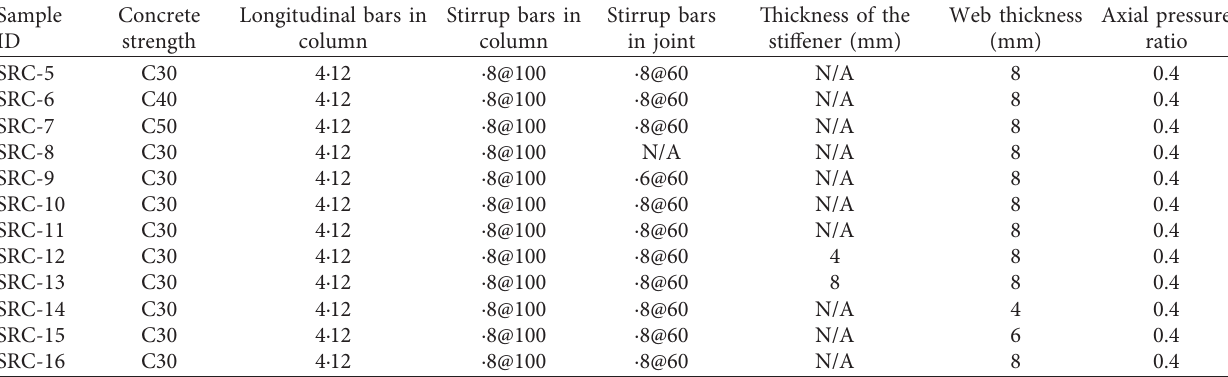
Table 10: FEM parameter analysis.